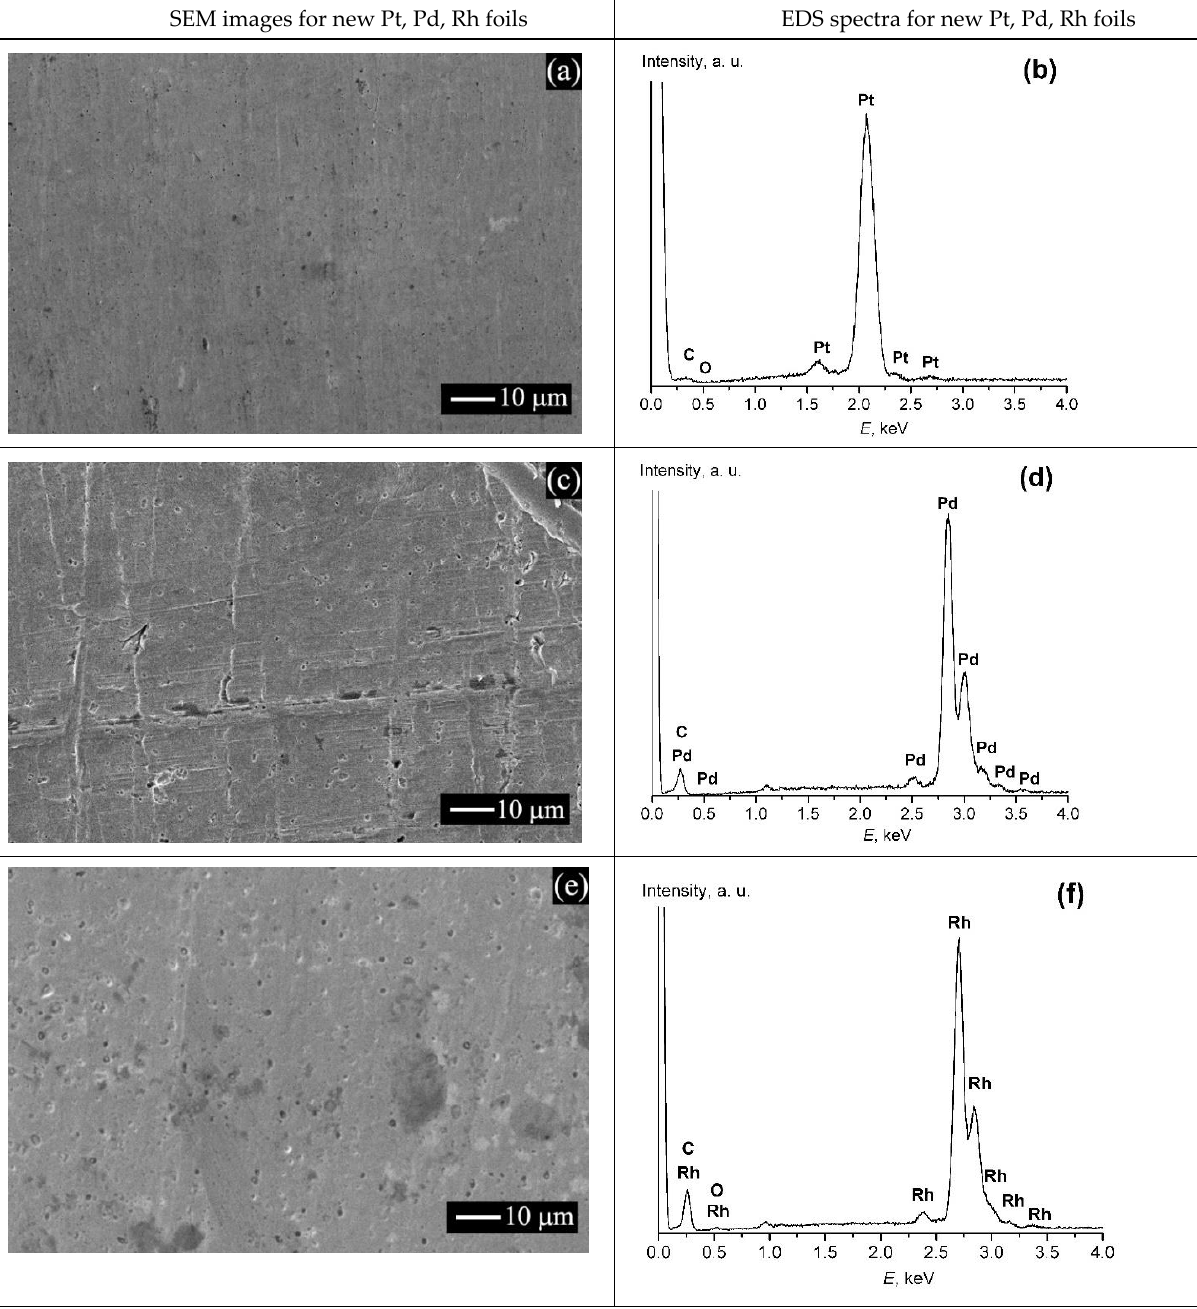
Figure 1. SEMimagesandEDSspectraforthenewsamplesPt(poly)( a , b ), Pd(poly)( c , d )andRh(poly) ( e , f ). Images were obtained in SE mode at E 0 = 20 keV and a × 1000 magnification. The EDS spectra in the energy range from 0 to 4.0 keV were recorded at E 0 = 20 keV and the energy of X-ray quanta 0–10.0 keV. According to EDS data, the new samples Pt(poly), Pd(poly) and Rh(poly) contain, in addition to metals, only C and O impurities; other impurities are not detected. It